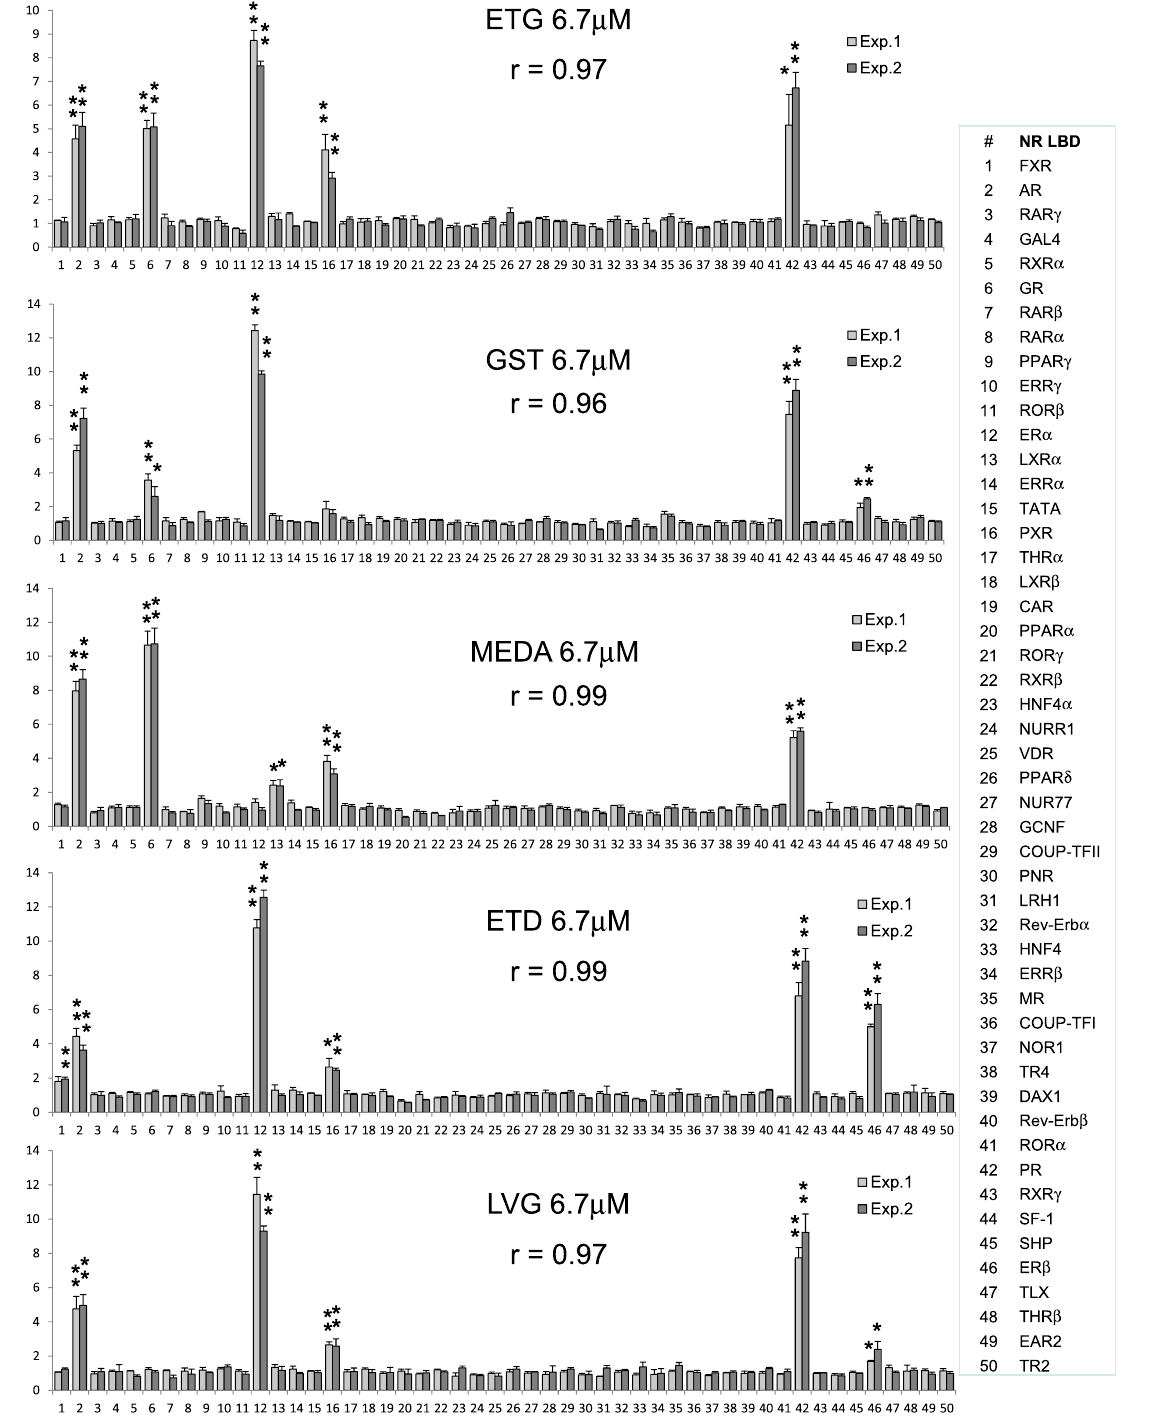
Figure 6. The reproducibility of progestins’ NR activity profiles. The NR data of two independent experiments are shown. Each profile is an average of three independent replicate FACTORIAL NR assays. All significant individual NR responses are marked by asteriscs (**P < 0.01; *P < 0.05). The similarity of NR activity profiles is calculated as the Pearson correlation coefficient r